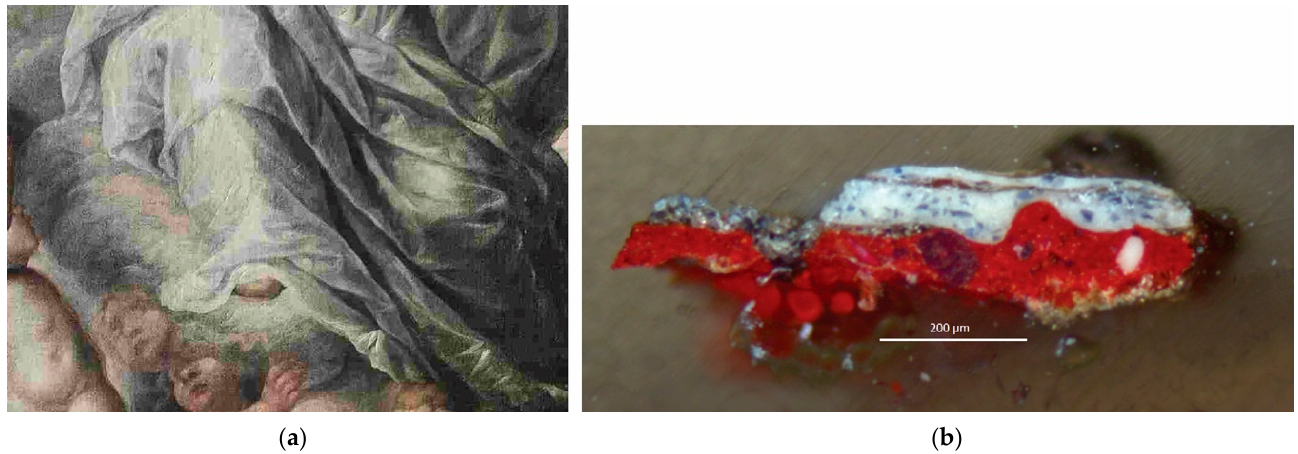
Figure 5. ( a ) Detail of the Virgin’s tunic in La Asunción. The area the sample was taken from is marked with a red dot. Detail of photograph by: Gerardo Hernández Rosales. Reproduction authorized by the Instituto Nacional de Antropología e Historia. ( b ) Cross-section under an optical microscope (10×). Image by LADiPA-COLMICH.